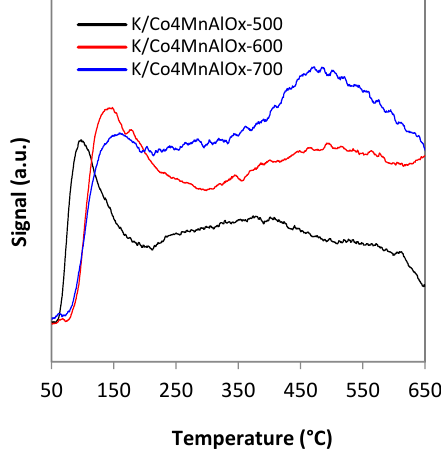
Figure 3. TPD-CO 2 profiles of the K/Co 4 MnAlO x mixed oxide calcined at different temperatures.